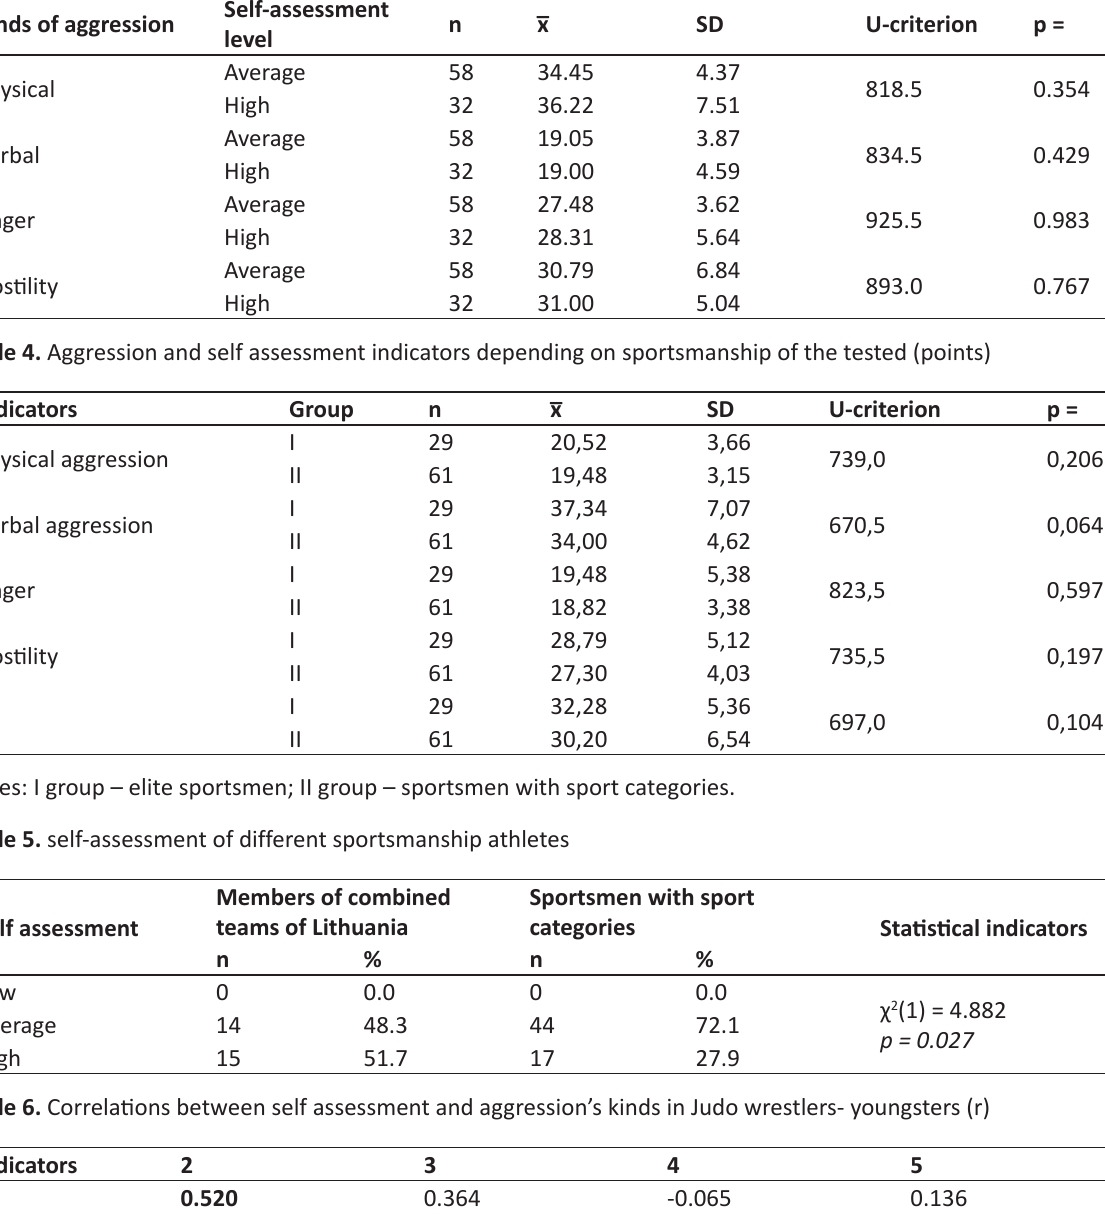
Table 3. Aggression indicators depending on self assessment of the tested (points) Kinds of aggression